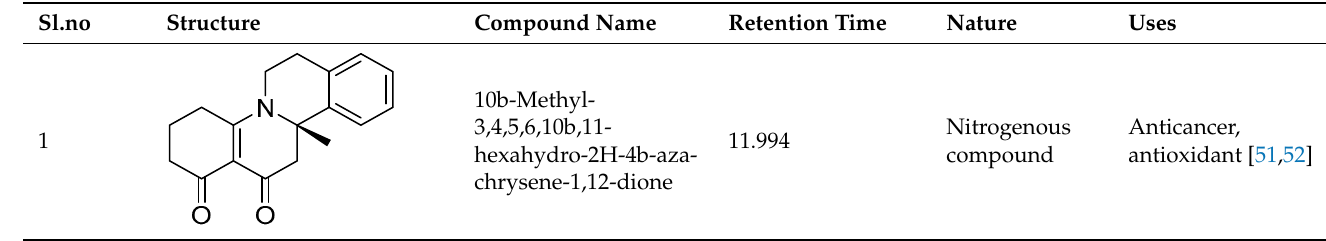
Table 8. LC-MS-based profiling of Methanol extract of F. arabica .